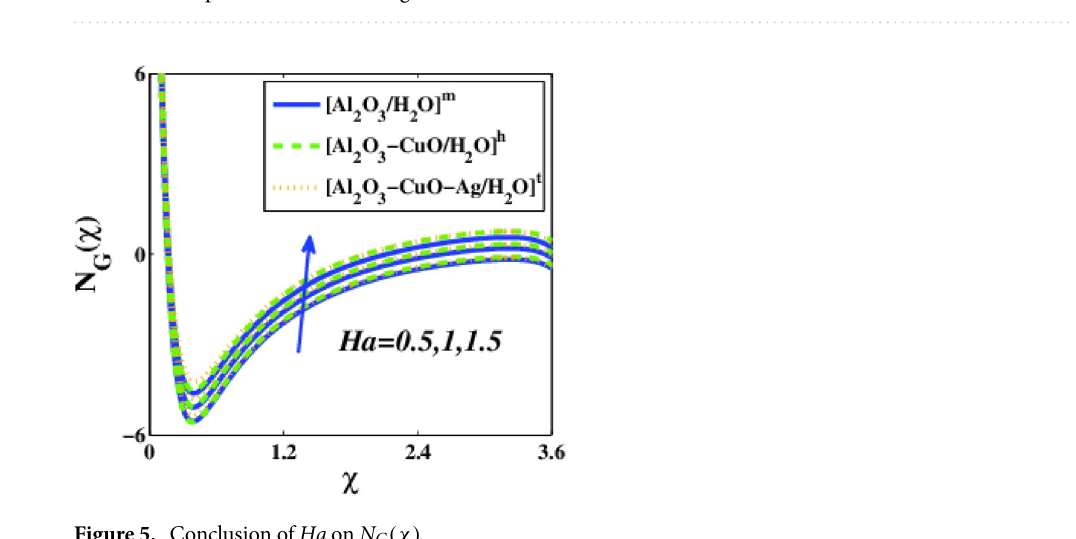
Table 3. Comparison models among NFs, HNFs and tri-HNFs of skin frictions.